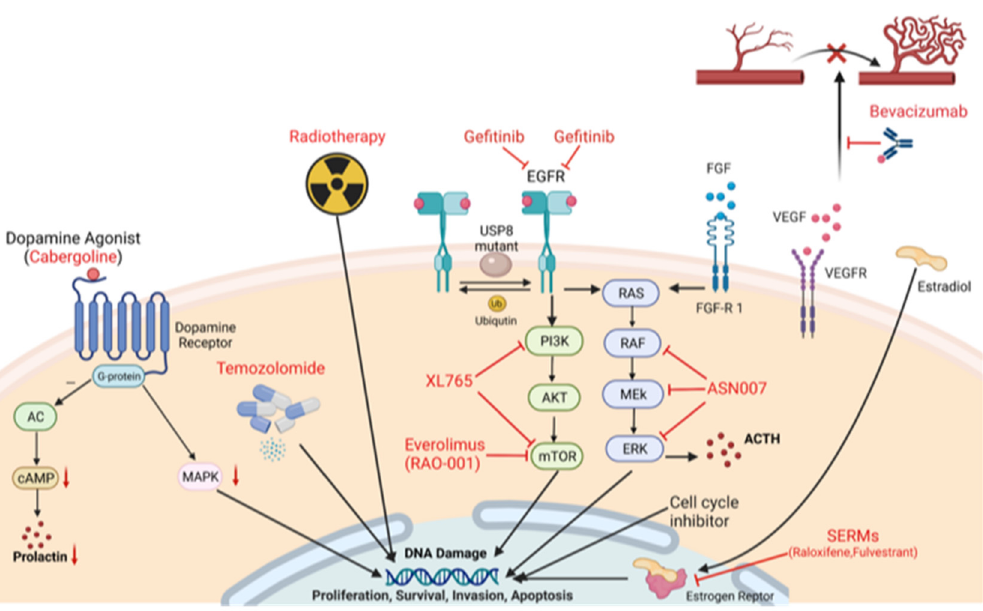
Figure 2. Schematic overview of target proteins and pathways related to the treatment of pituitary adenomas. As general therapeutic approaches, VEGF inhibition with Bevacizumab, EGFR inhibition with gefitinib, the Raf/MEK/ERK pathway by inhibitors such as ASN007, mTOR pathway inhibition with Everolimus and XL-765 as well as chemotherapy with radiation or temozolomide are discussed. As a more specialized therapy, application of dopamine agonists such as Cabergoline and anti-estrogens is the subject of intense research.